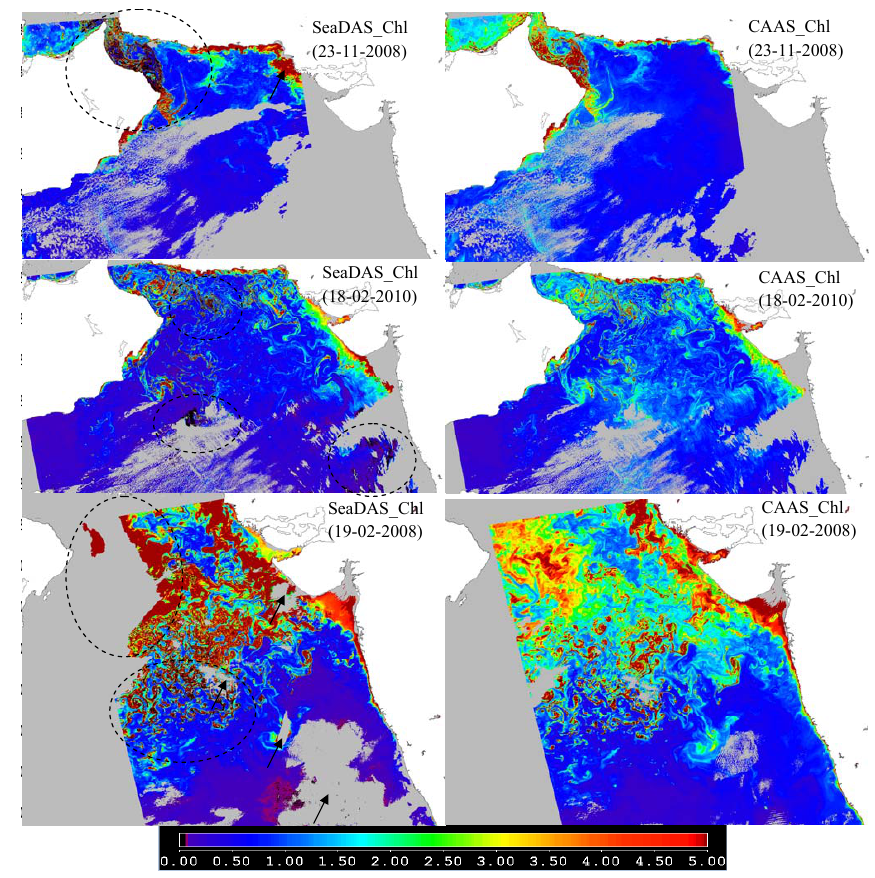
Fig. 10. Chlorophyll concentrations derived from the Aiken Case 2 bio-optical algorithm using MODIS-Aqua derived remote sensing reflectances from the SeaDAS and CAAS algorithms. 1110